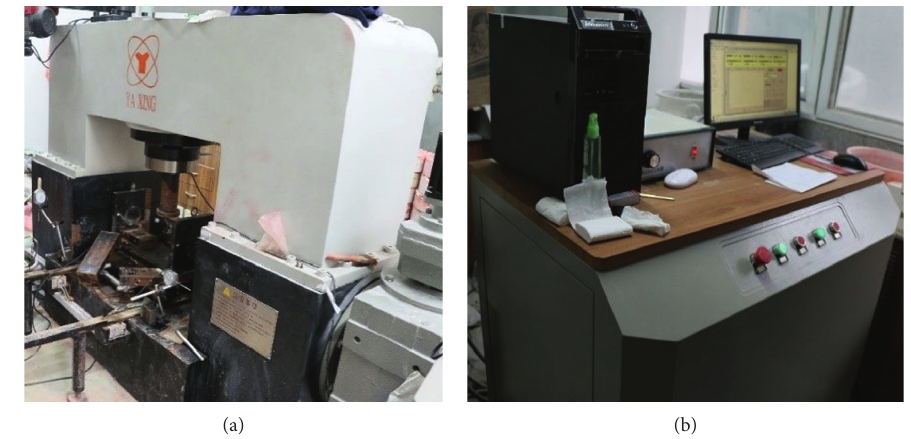
Figure 5: Shear test equipment. (a) Main engine. (b)